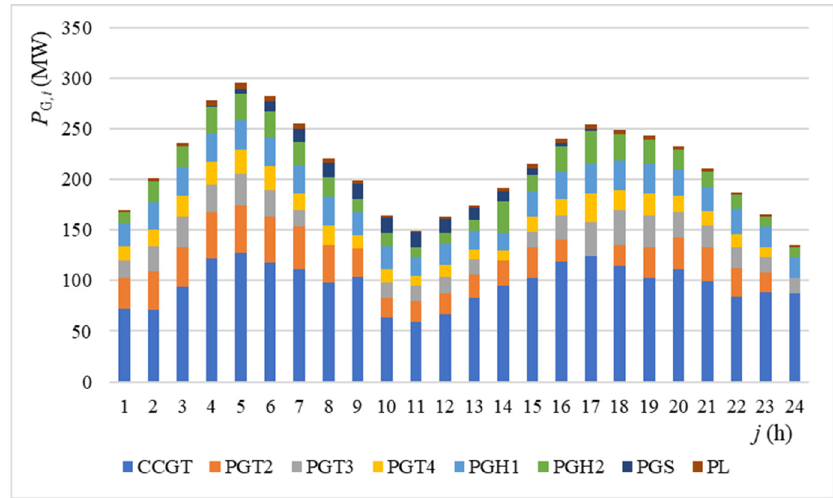
Figure 14. Optimal generation scheduling for case 2–sub-case 3.